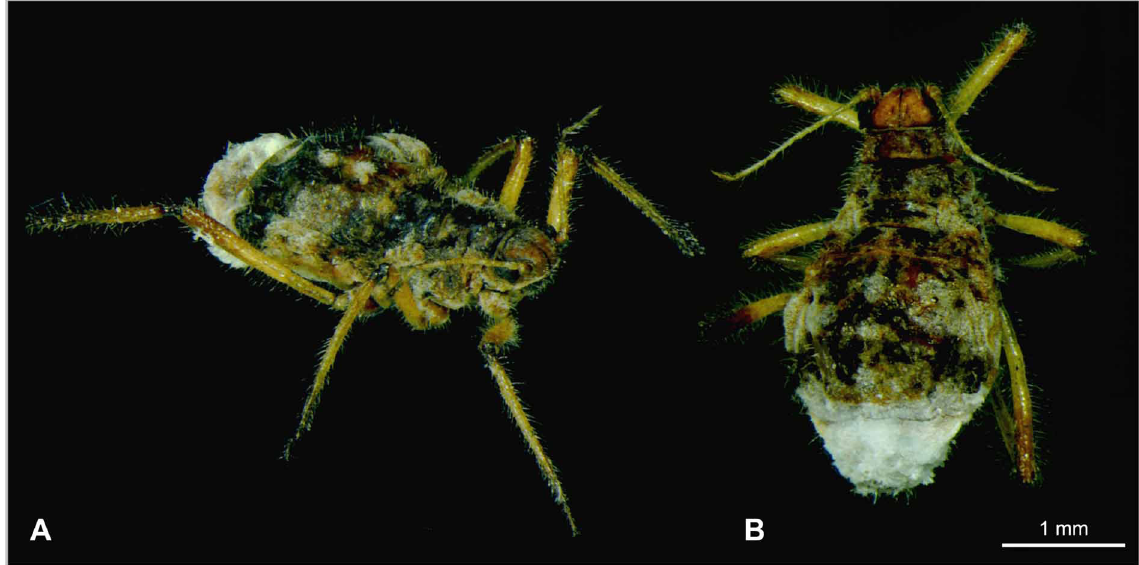
Fig. 95. Cinara (Cinara) pinihabitans (Mordvilko, 1895). Ovipara (freeze-dried